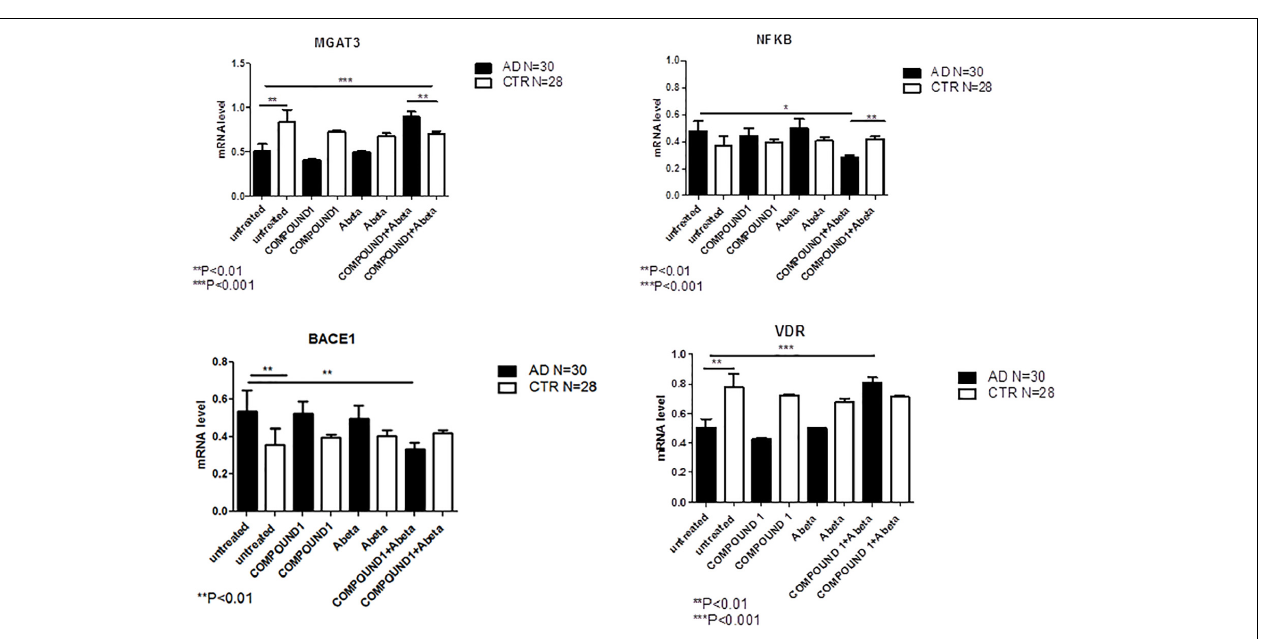
FIGURE 6 | MGAT3 , NF- κ B , BACE1 , and VDR gene expression in PBMCs from AD patients and control subjects treated with A β (48 h) or untreated, and COMPOUND 1 (24 h) and COMPOUND 1 (24 h) + A β (24